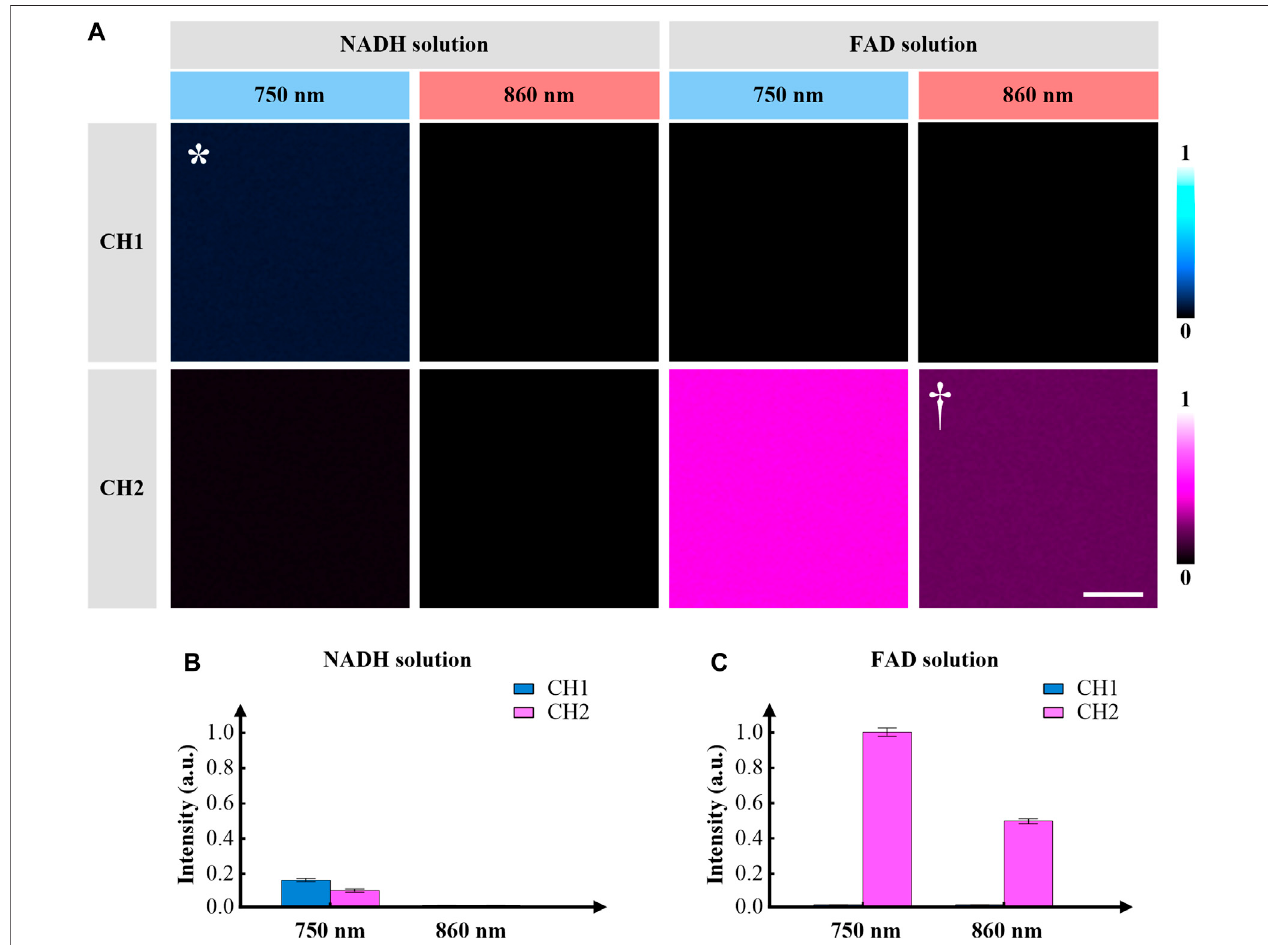
FIGURE 3 | (A) Representative TPF images of NADH and FAD solutions using pixel-to-pixel wavelength-switching, equivalent 8 μ s/pixel, 100 × 100 pixels. The solutionsareexcitedat750and860 nm,andthesignalsarecollectedatthewavelengthrangesof415 – 455 nm(CH1) and500 – 550 nm(CH2). Theexcitation/detection combinations of 750/415 – 455 nm and 860/500 – 550 nm are used to collect TPF images of NADH (marked by * ) and FAD (marked by † ), respectively. (B) Fluorescence intensities of different excitation/detection combinations, when imaging the NADH solution. (C) Fluorescence intensities of different excitation/detection combinations, when imaging the FAD solution. Error bars represent standard error. The scale bar is 5 μ m.